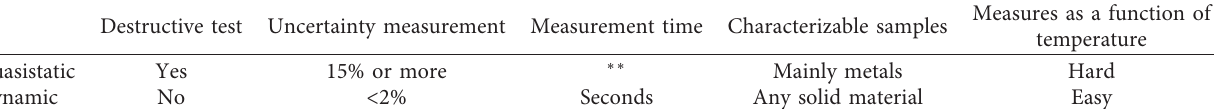
Table 1: Comparison between quasistatic and dynamic methods [14].